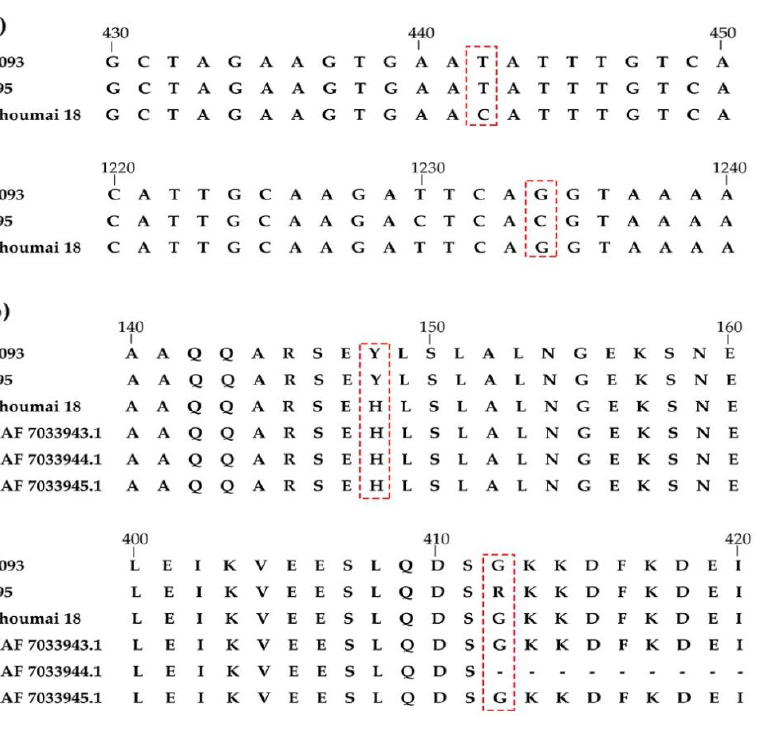
Figure 4. Sequence variation in the TraesCS3D01G466100 cDNA structure of Zhoumai 18 and line 495 wheat for resistance to pre-harvest sprouting (PHS). The single nucleotide polymorphisms (SNPs) in the coding DNA sequence (CDS) are indicated by vertical lines; each SNP is indicated by the enlarged codons and their encoded amino acids.